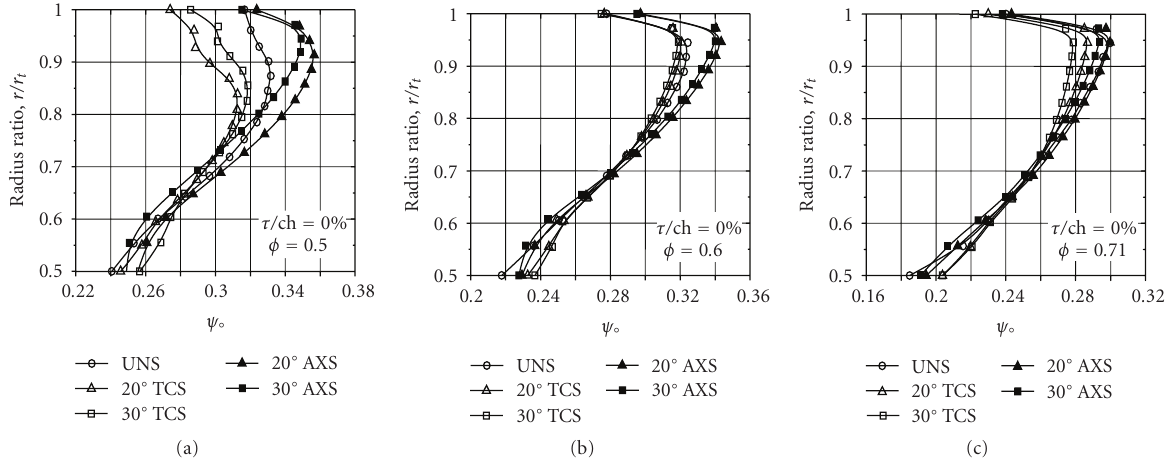
Figure 7: Variation of total pressure coe ffi cient at the rotor exit.